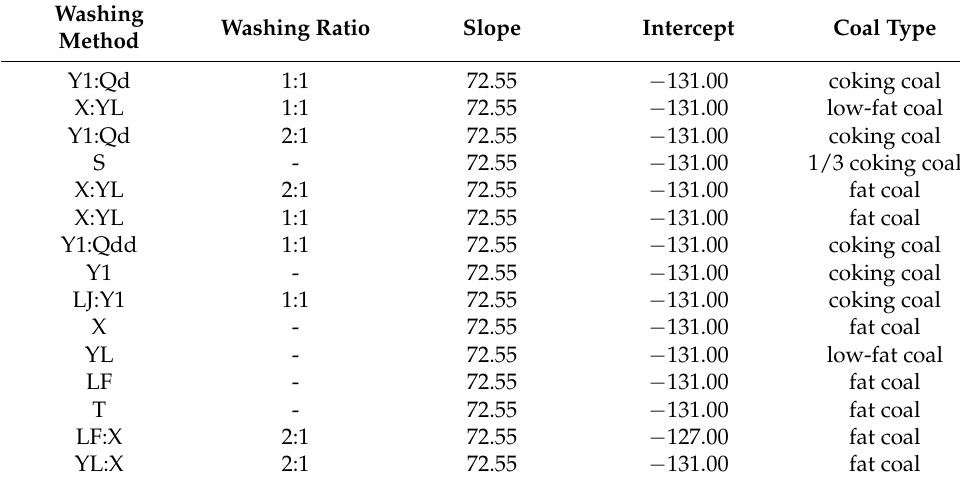
Table 9. Parameters for the online ash monitor in production system #1.